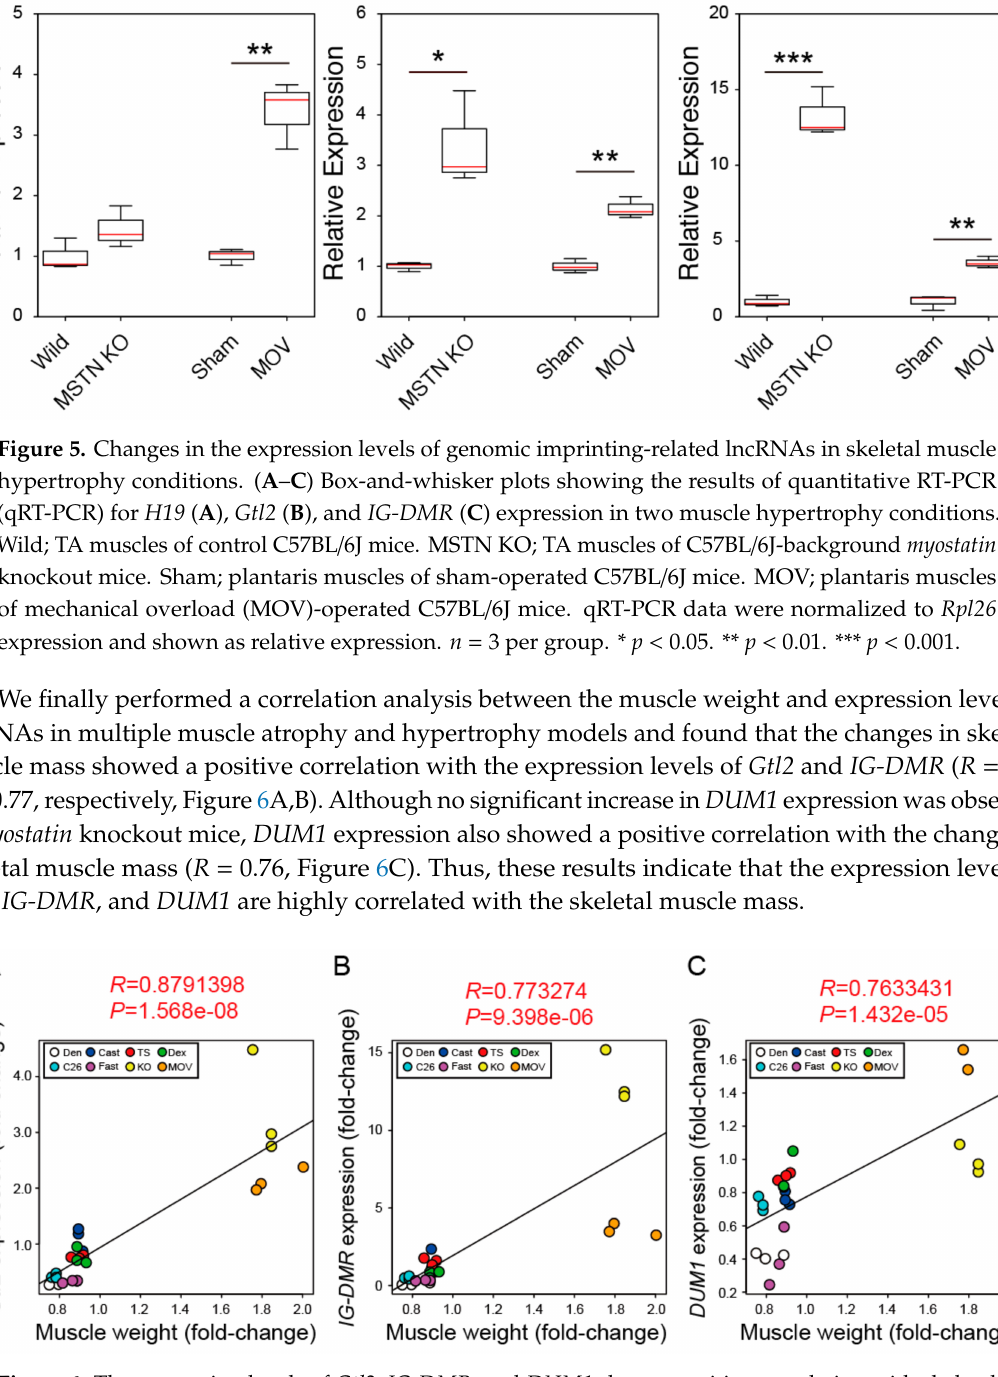
Figure 6. The expression levels of Gtl2 , IG-DMR , and DUM1 show a positive correlation with skeletal muscle weight. ( A – C ) Pearson correlation plot with a coe ffi cient of correlation ( R ) and p -value ( P ) between skeletal muscle weight (fold-change with respect to control) and Gtl2 ( A ), IG-DMR ( B ), and DUM1 ( C ) expression (fold-change with respect to control) in multiple muscle atrophy and hypertrophy models. Each dot indicates the independent samples ( n = 3 per group). Dots with white, blue, red, green, light blue, purple, yellow, and orange indicate the denervated tibialis anterior (TA) muscles of C57BL / 6J mice (Den), the casting-operated TA muscles of C57BL / 6J mice